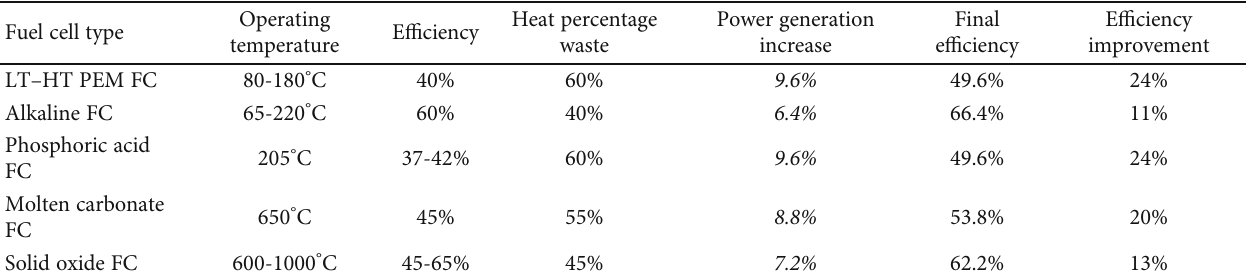
Figure 2: TEG and HT-PEM FC energy harvesting setup (adapted from [3]). Table 1: E ffi ciency improvement of fuel cells incorporating thermoelectric devices (adapted from [2]).